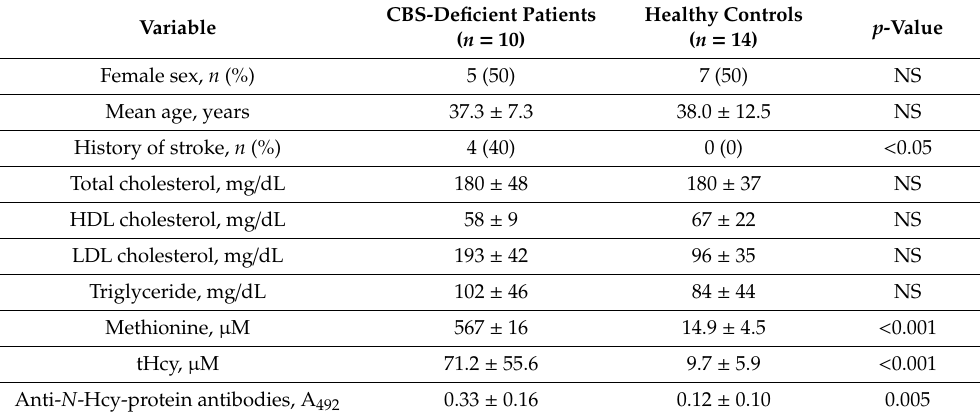
Table 1. Characteristics of cystathionine β -synthase (CBS)-deficient patients and healthy